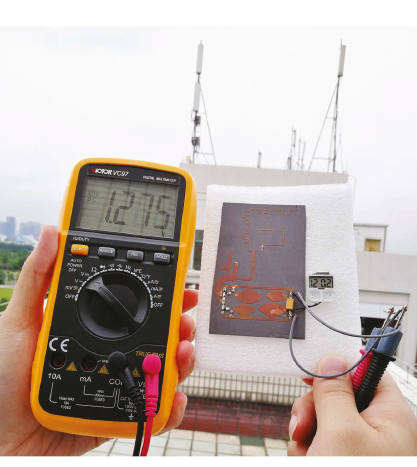
Figure 14: Rectenna outdoor measurement at about 25 meters from cellular base station.